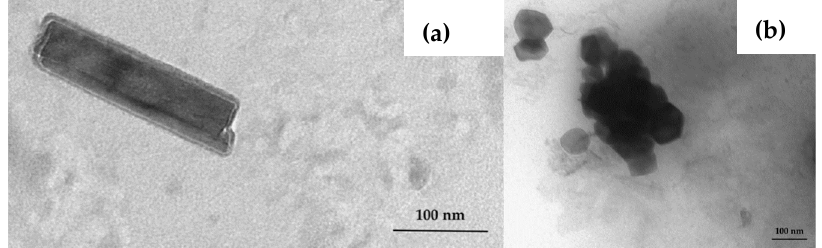
Figure 3. TEM images of PC–NCs ( a ) and PS–NCs ( b ) (scale 100 nm).